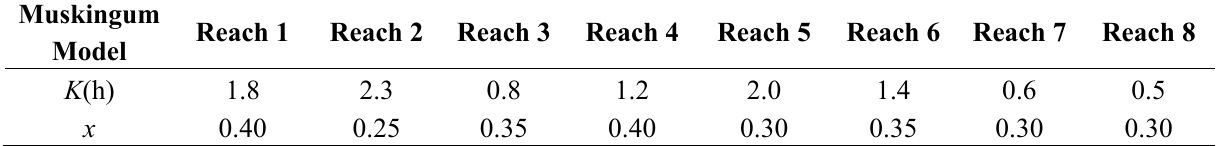
Table 5. The Calibration Result of the Routing, Schemes I and II. Muskingum